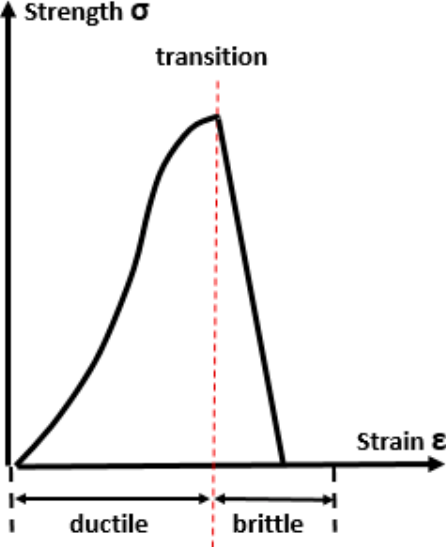
Figure 15. Loading curve of the ice sheet during strain rate increase.